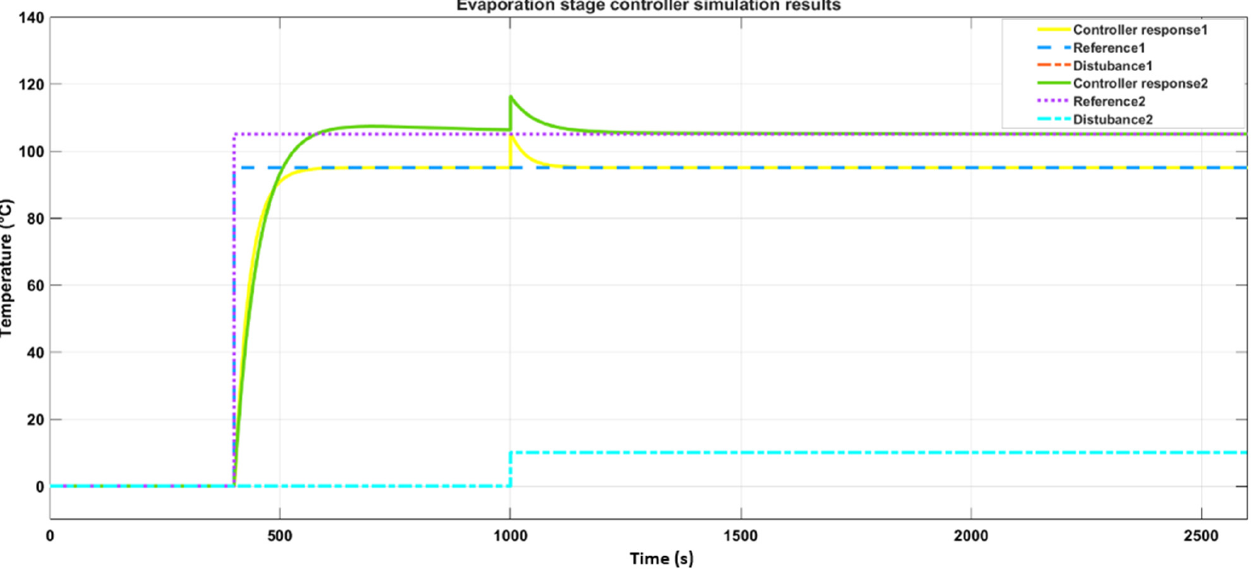
Figure 7. Simulation results for the evaporation stage temperature controller.